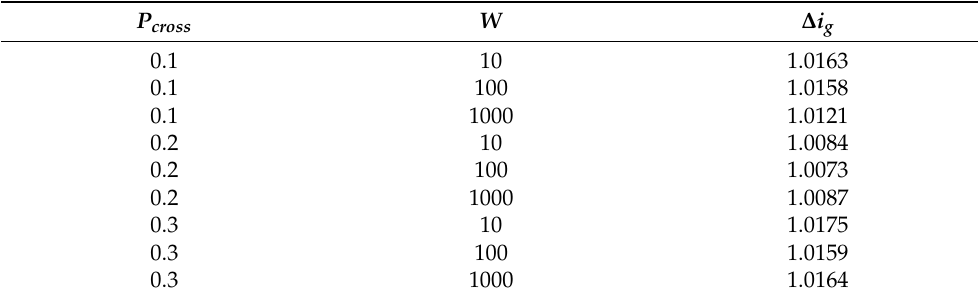
Table 3. Obtained results from the sensitivity test considering G = 6.